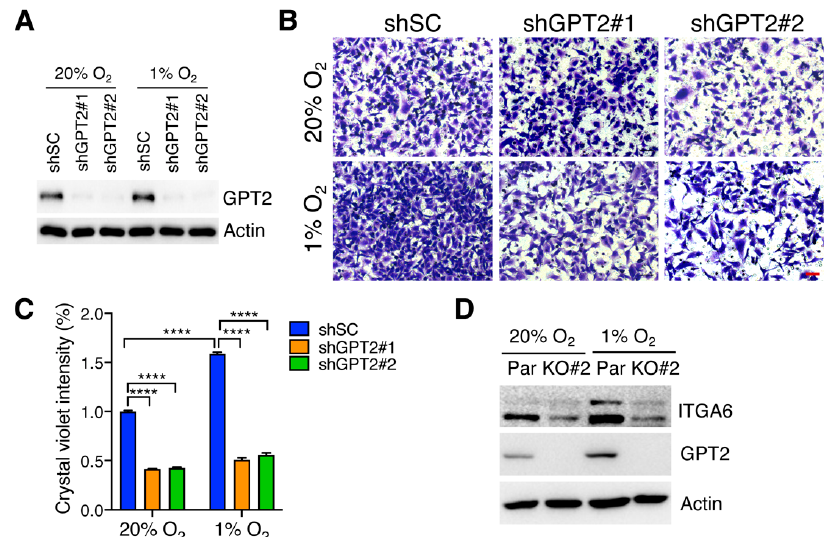
Figure 4. GPT2 promotes GBM cell migration in vitro. ( A ) Immunoblot analysis of indicated proteins in SC and GPT2 knockdown U251MG cells exposed to 20% or 1% O 2 for 24 h. ( B , C ) Migration of SC and GPT2 knockdown U251MG cells under 20% and 1% O 2 . Representative images are shown in ( B ). Scale bar, 50 μ m. Cell migration was quantified in ( C ) (mean ± SEM, n = 3). **** p < 0.0001 by two-way ANOVA with Tukey’s test. ( D ) Immunoblot analysis of indicated proteins in parental (Par) and GPT2 KO#2 U251MG cells exposed to 20% or 1% O 2 for 48 h.